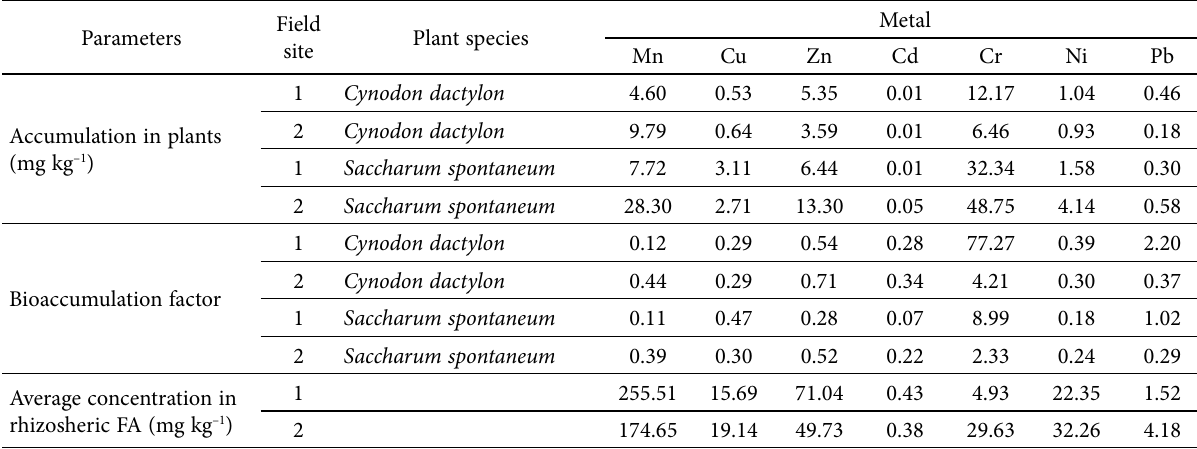
Table 2. Metal accumulation in dominant plant species growing on different aged fly ash dump sites (mg kg –1 ), bioaccumulation factors, and concentration in the rhizospheric fly ash samples (mg kg –1 )